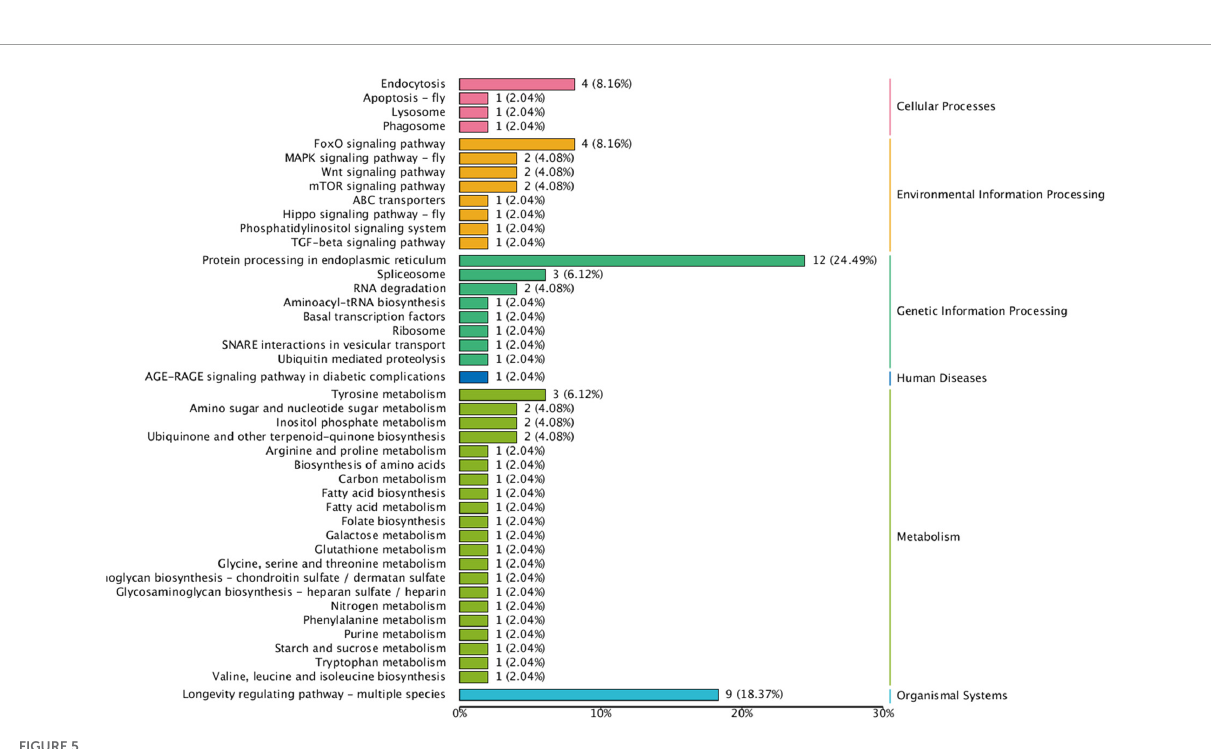
Frontiers in Ecology and Evolution